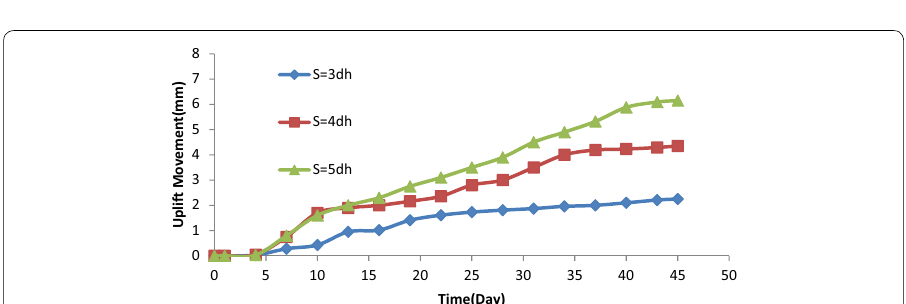
Fig. 30 Variation of uplift movement with time for pile group of L/D